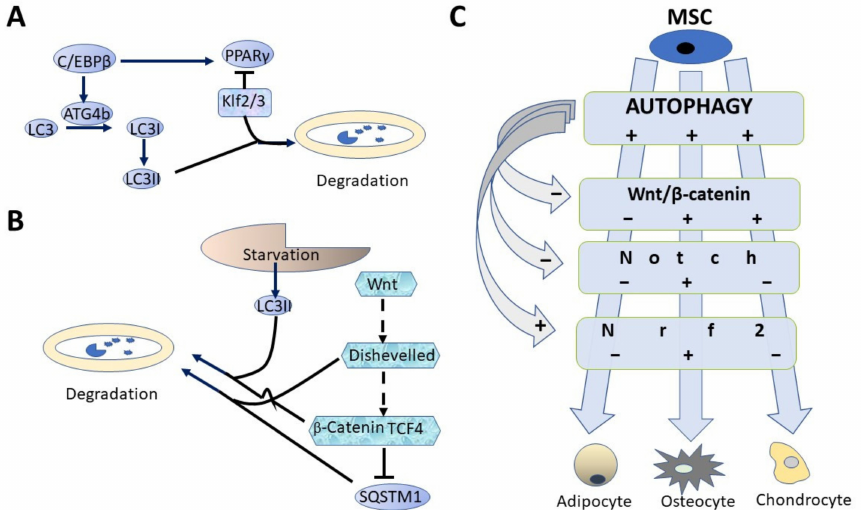
Figure 2. Relationship between autophagy and intracellular signaling participating in MSC differenti- ation. ( A ) adipogenesis transcription factor C/EBP β activates proteinase ATG4b, which induces LC3 maturation. LC3II binds factors Klf 2/3 and transfers them into autolysosome, thereby eliminating PPAR γ suppression by Klfs [69]. ( B ) LC3II and SQSTM1 perform autolysosomal degradation of Disheveled (Dvl) and β -catenin. This effect antagonizes SQSTM1 suppression by Wnt/ β -catenin signaling [71,72]. ( C ) autophagy is a necessary factor of MSC differentiation; Wnt and Notch weaken adipogenesis and reinforce osteogenesis. The existence of selective relationships between autophagy and cell signaling creates an opportunity to regulate efficiency of MSC differentiation as a factor of tissue